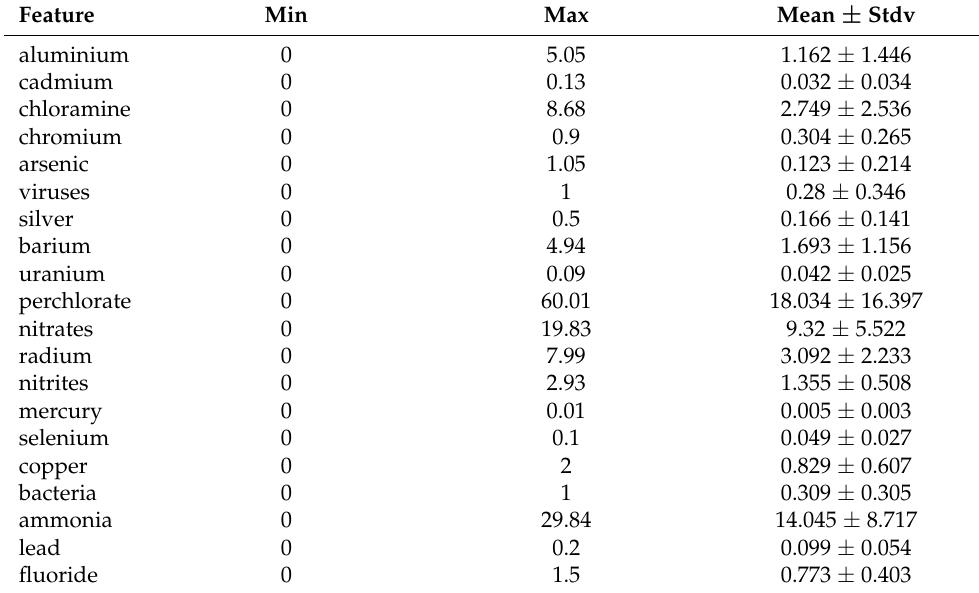
Table 1. Statistical Description of the Numerical Features.